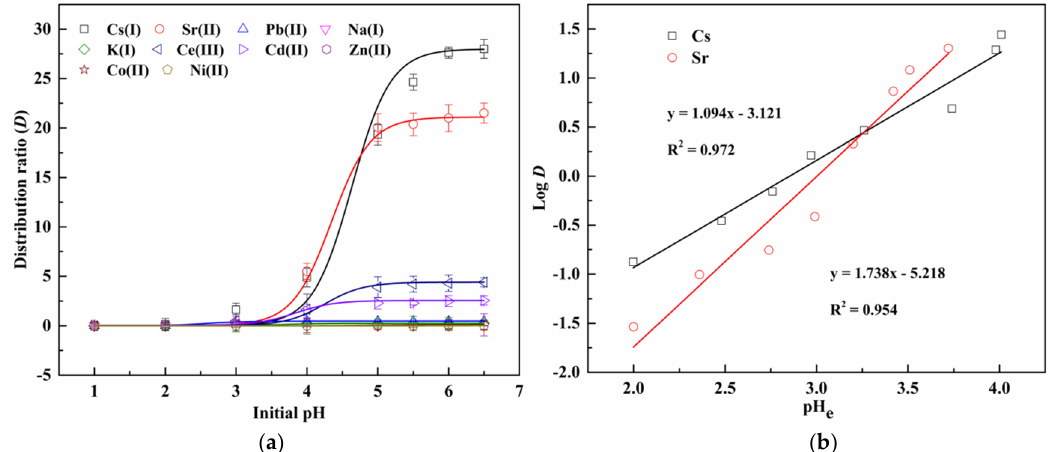
Figure 3. ( a ) Dependence of the distribution ratio ( D ) of the tested elements onto SC4A with a change in initial pH; and ( b ) relationship between log D and pH e . Conditions: T = 298 K, [SC4A] (o) = 1 ˆ 10 ´ 3 M,